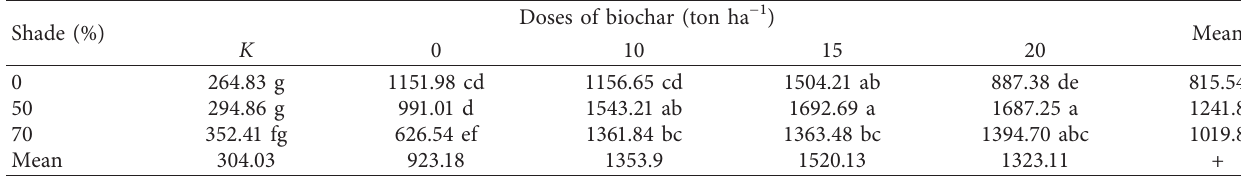
Table 9: Effects of biochar and shade application on ammonium